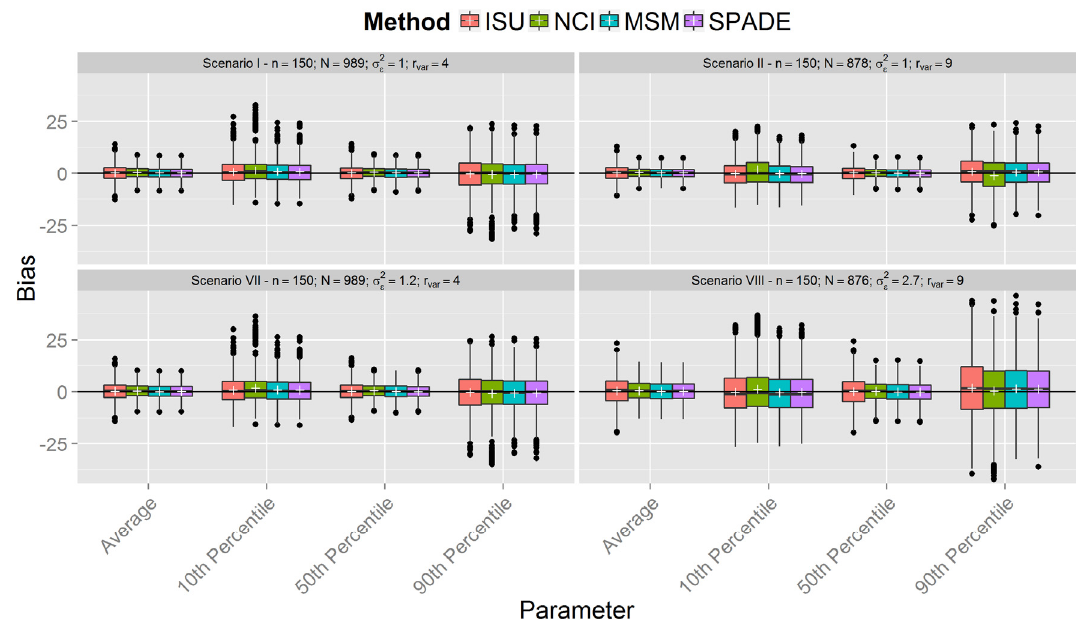
Figure 1. Boxplot of biases calculated for each method and scenarios with n = 150 for samples with estimated between ‐ person variance different from zero for all methods (N denotes the number of usable samples).